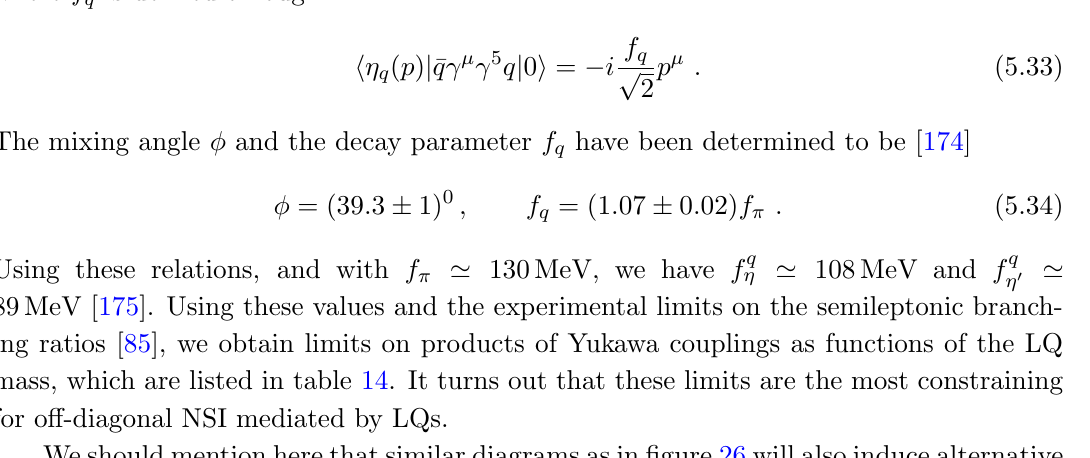
Table 14 . Constraints on couplings and the LQ mass from semileptonic tau decays. Exactly the same constraints apply to (cid:21) 0 couplings, with m ! replaced by m (cid:31) . where f is de(cid:12)ned q